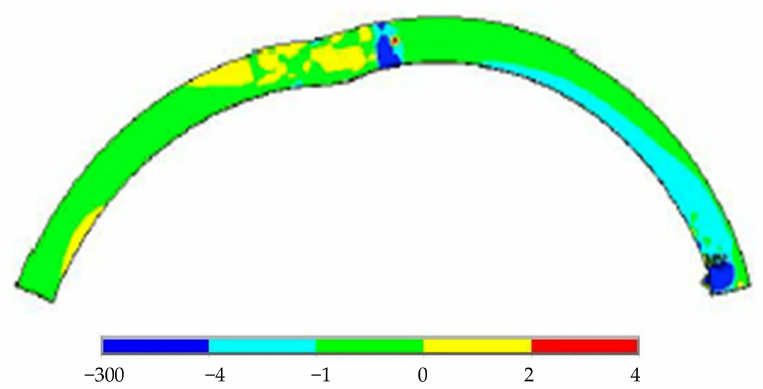
Figure 14. Stress state S y in [N/mm 2 ] at the end of Set 2.6 (0.15